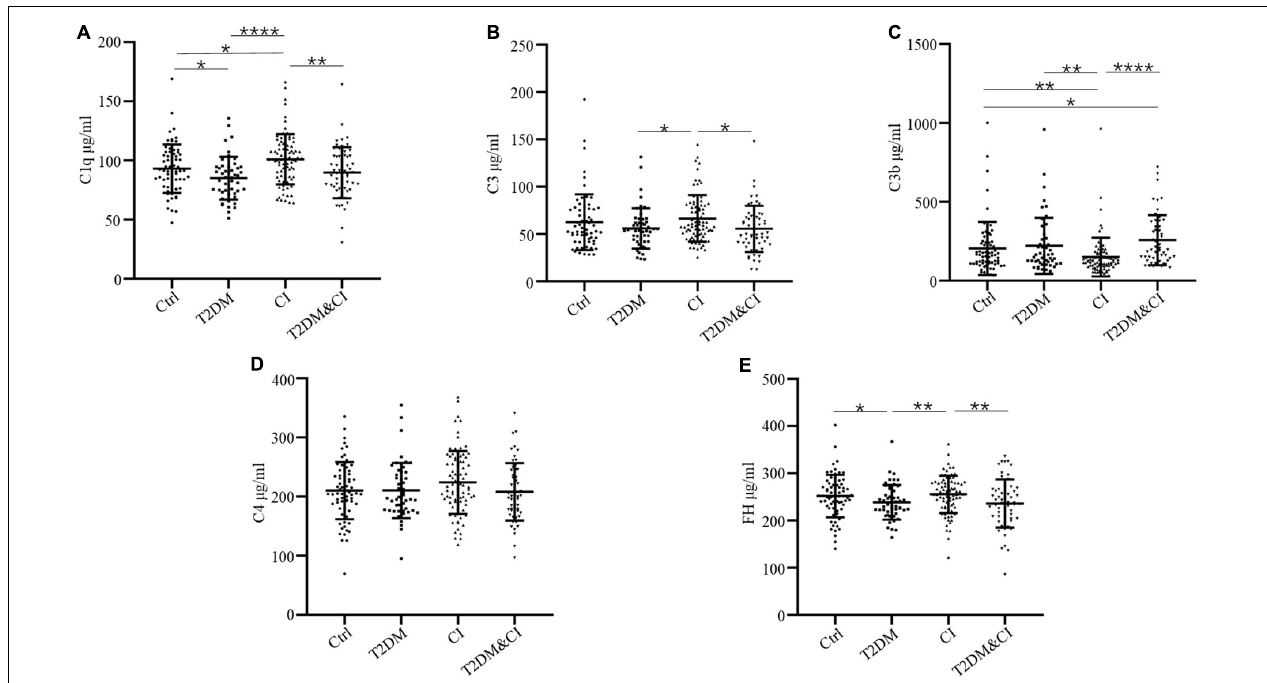
FIGURE 1 | Serum levels of complement proteins in the cross-sectional control (Ctrl), diabetes mellitus only (T2DM), cognitive impairment only (CI) and diabetes combined with cognitive impairment groups (T2DM&CI). Each point represents the value for an individual control or participant, and the horizontal line in point clusters represents the mean level and standard deviation for that group. Bar graphs indicate statistical significance of differences in values for each two-group comparison, calculated by Mann–Whitney U -test pairwise comparisons (* p < 0.05; ** p < 0.01; *** p < 0.005; **** p < 0.0001). See Table 1 for statistical